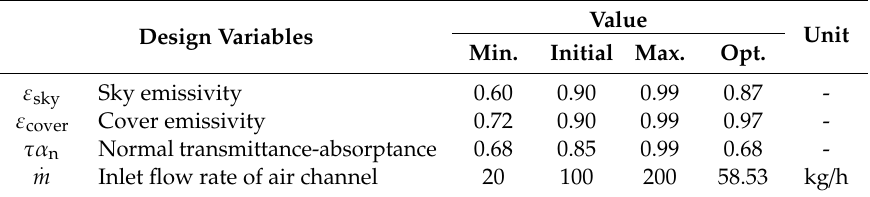
Table 4. Target variables and optimum values obtained via sensitivity analyses.